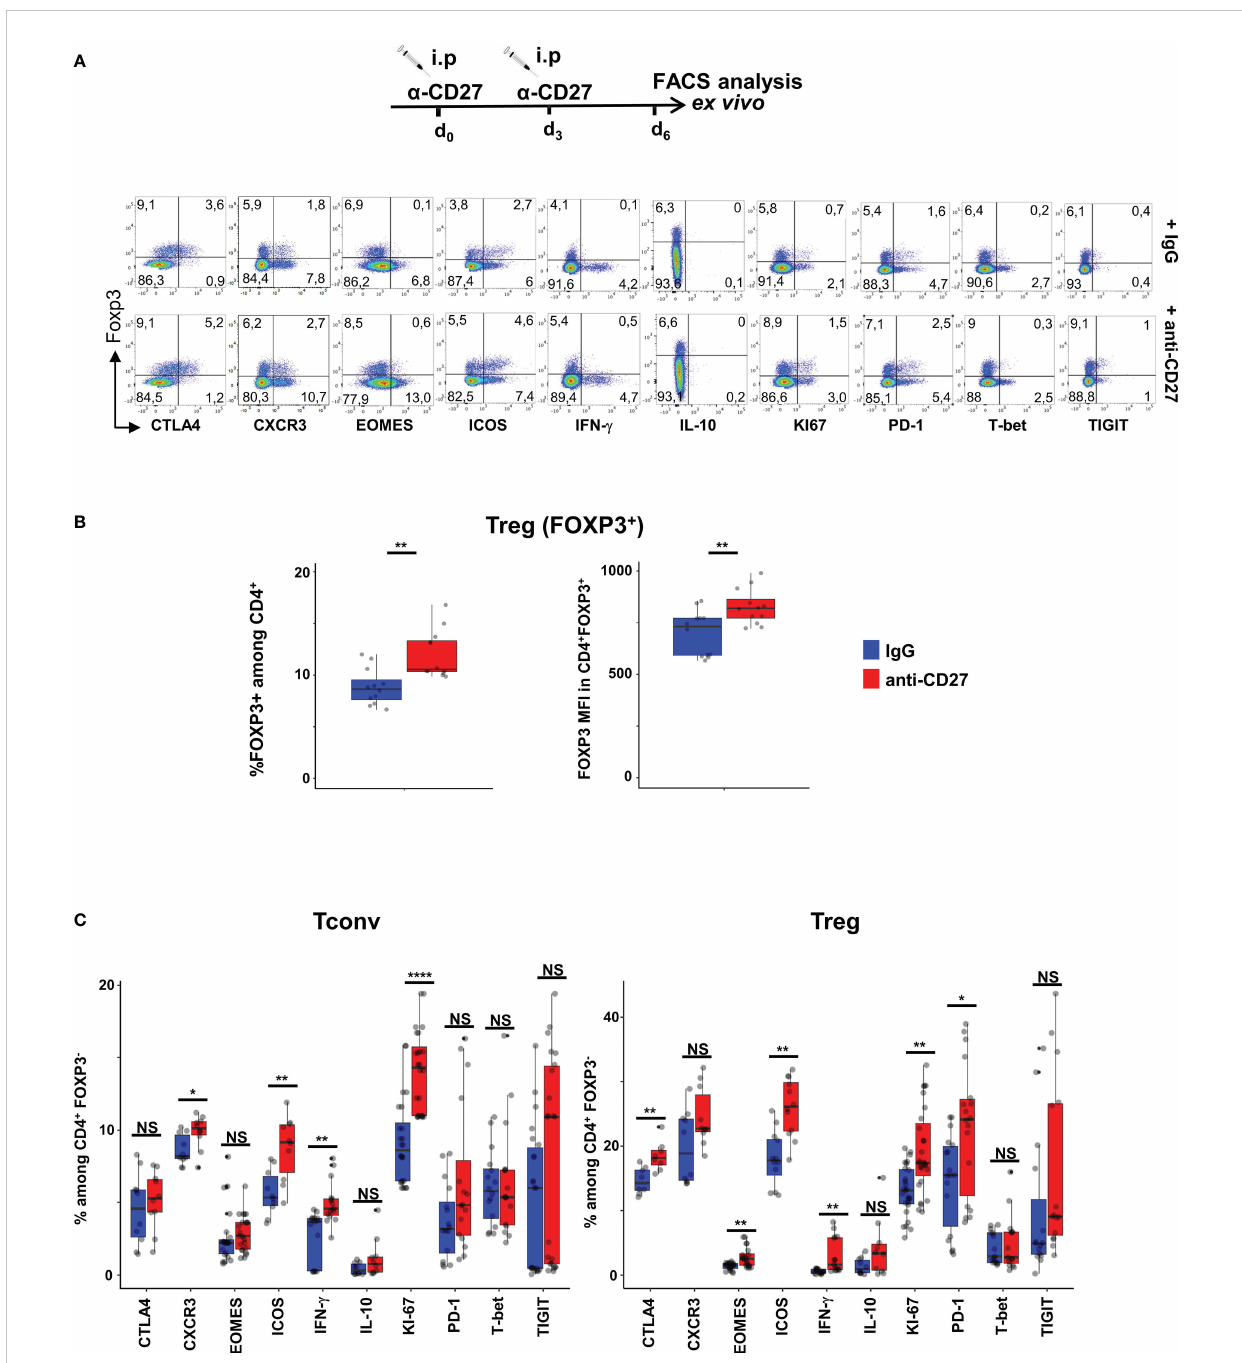
FIGURE 2 Injection of agonistic anti-CD27 mAb induces some features of Th1-type Tregs. WT mice were injected i.p. with agonistic anti-CD27 mAb (at days 0 and 3) and spleen cells were analyzed ex vivo by fl ow cytometry at day 6. (A) Spleen cells were stained for CD4, Foxp3 and the indicated markers? Singlets were selected by gating events in the diagonal of FSC-H vs FSC-A plots. Representative fl ow cytometry plots of indicated marker on gated viable CD4 + cells. (B) Proportion of Tregs and intensity of Foxp3 expression. (C) Proportion of CD4 + Tregs and Tconvs expressing the proliferation marker Ki67, transcription factors (Eomes, T-bet), cytokines (IFN- g and IL-10) and inhibitory receptors (TIGIT, ICOS, CTLA-4 and PD-1). Data are from 3 independent experiments with 4 mice per group. Bars represent median ± SD. Unpaired t-test was used to determine statistical differences followed by FDR correction for multiple comparisons (*p < 0.05; **p < 0.01; ****p < 0.0001; ns, not signi fi